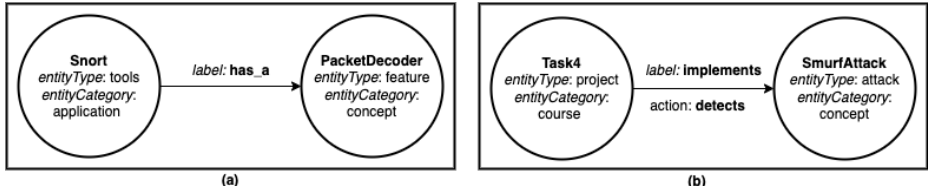
Figure 4. Examples of entity-relation-entity triples in our ontology, as given in Section 3.1.4. ( a ) The first figure represents the entity “Snort” and its attributes, entity ID, type as “tools” and category as “application”. The “has_a” relation follows with another entity “PacketDecoder” which is of the type "feature" under the category “concept”. ( b ) The second figure shows the relational attribute “action” as “detects”, to show the additional activity performed during the interaction between the project, “Task4” and attack type entity